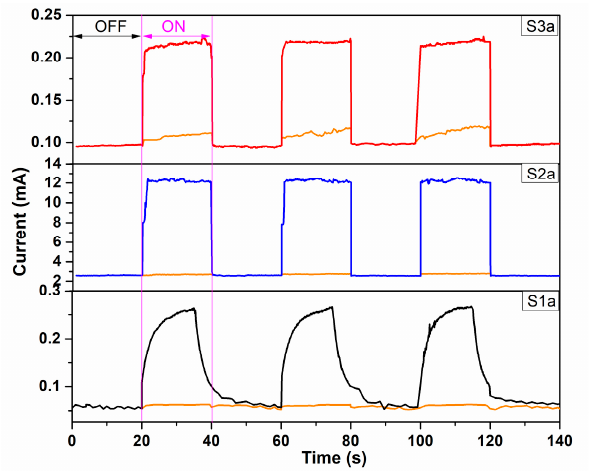
Figure 9. UV and Vis time-dependent photo-detective properties of the sensors at light exposure (ON/OFF = 20 s). (ON/OFF = 20